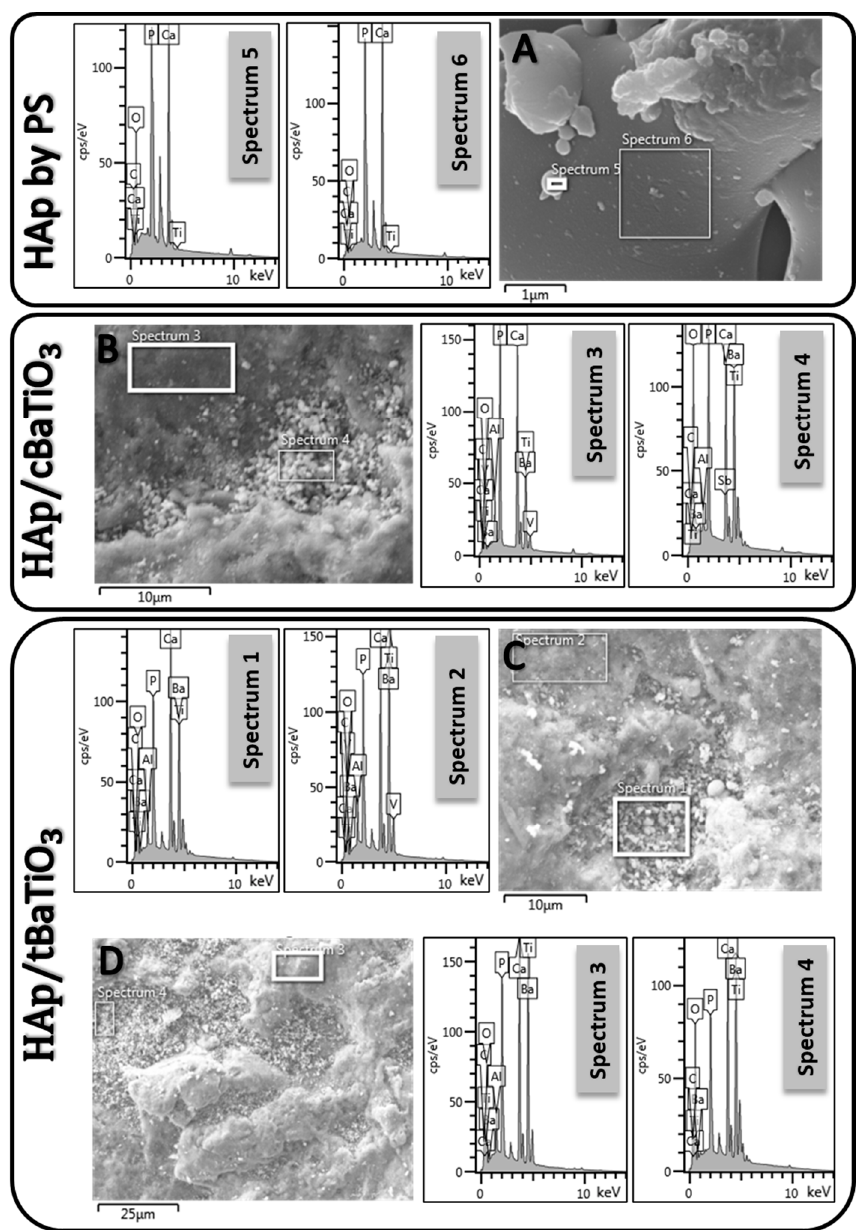
Figure 5. SEM/EDS images of HAp PS ( A ), 80%/20% (m/m) HAp/BaTiO 3 using BT cubic nanopow- ders ( B ) and tetragonal micropowders ( C , D ). The marked areas correspond to the EDS spectra shown on the same line.